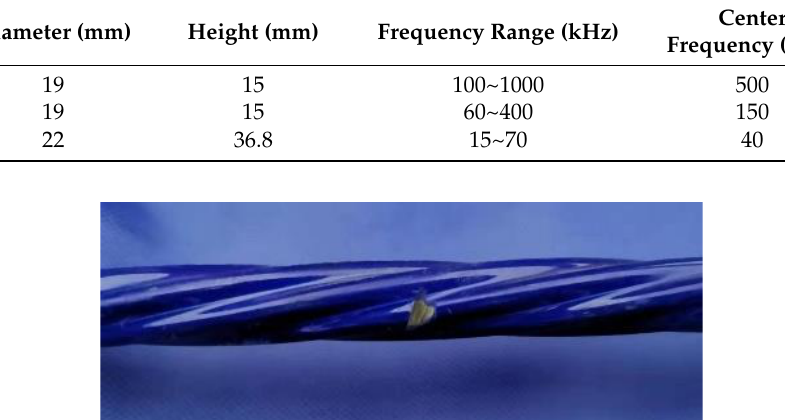
Figure 1. Tensile testbed of steel strand. Table 1. Parameters of the acoustic emission sensors.